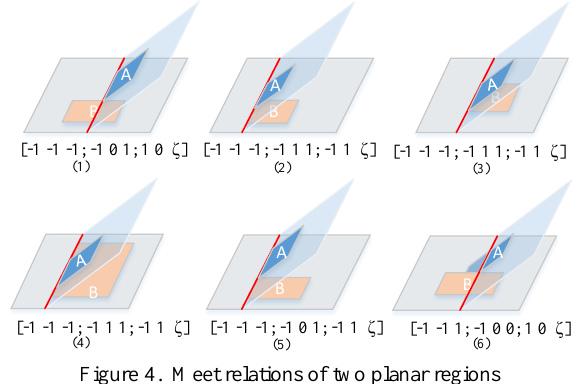
Figure 4. Meet relations of two planar regions